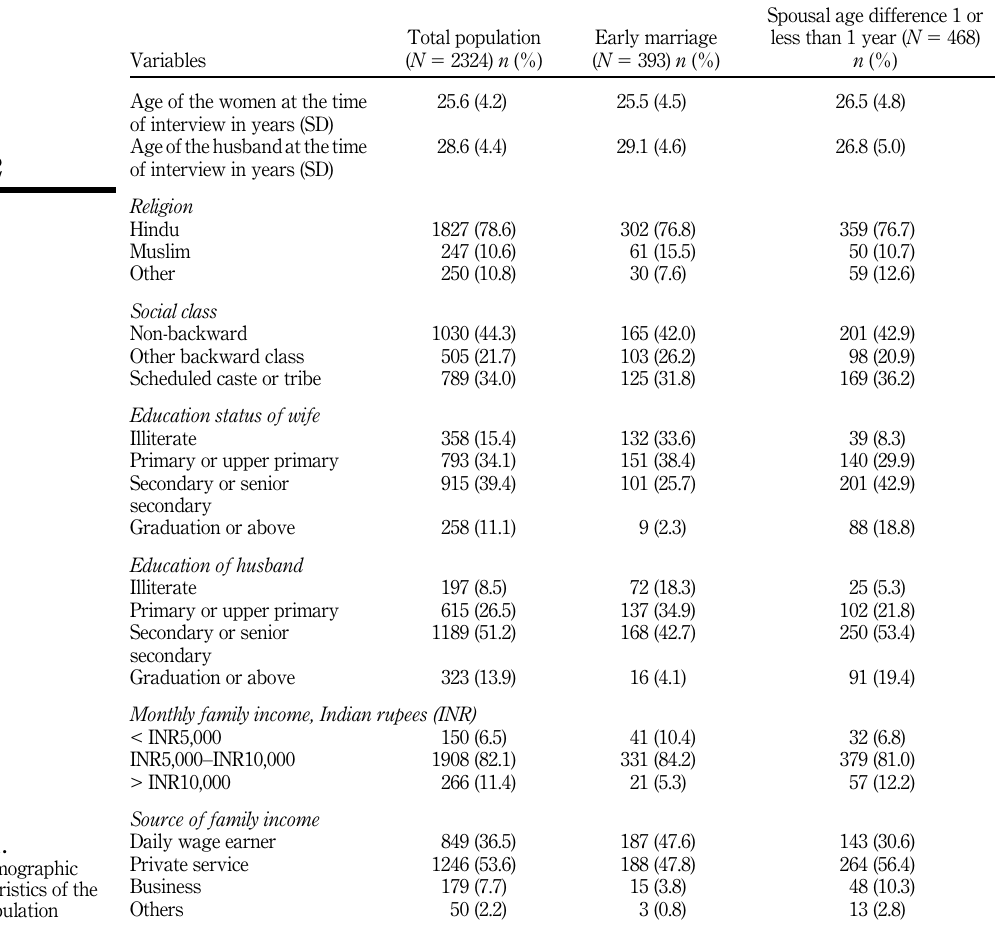
Table 1. Sociodemographic characteristics of the total